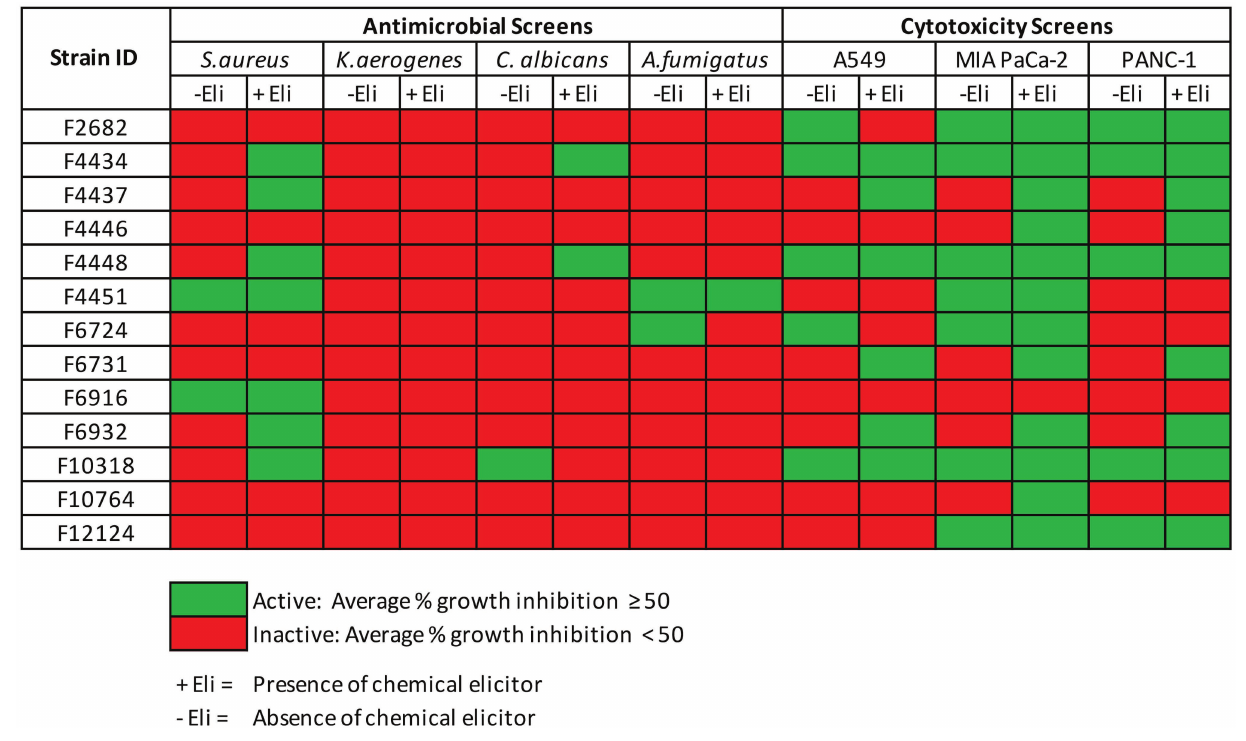
FIGURE 3 | Antimicrobial and cytotoxic screens hits from 45 fungal strains grown in CF02LB and CF18LB media in the presence and absence chemical